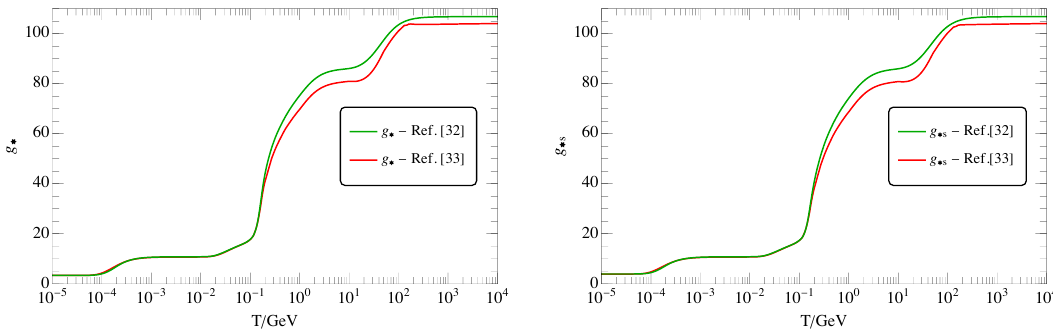
Figure 14 . Effective number of SM relativistic degrees of freedom contributing to the energy density g ( T ) and to the entropy density g ( T ) as a function of the temperature. We report the ∗ ∗ s results of ref. [32] (green solid line) and ref. [33] (red solid